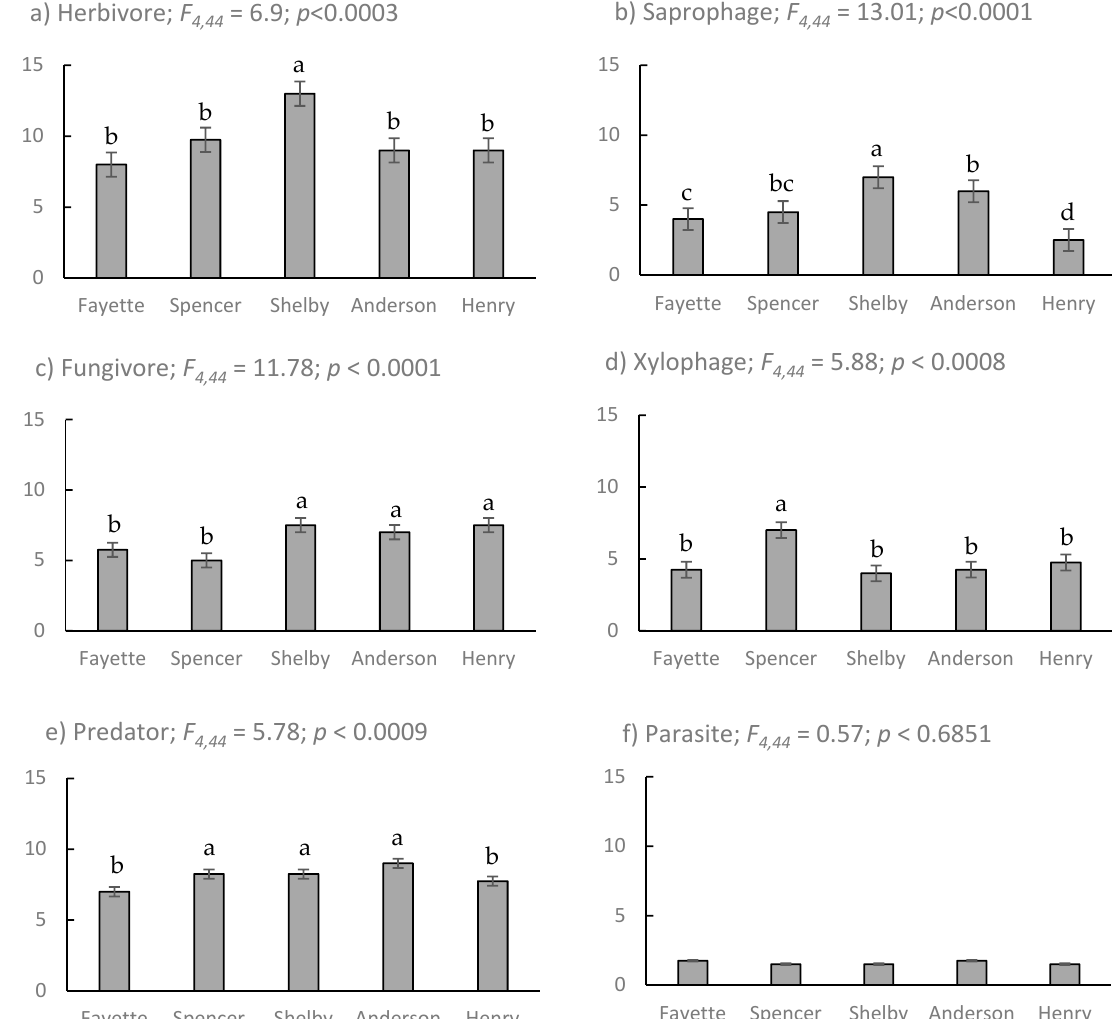
Figure 4. Coleopteran feeding guild abundance at five forested sites in north central Kentucky, including ( a ) herbivores, ( b ) saprophages, ( c ) fungivores, ( d ) xylophages, ( e ) predators, and ( f ) parasitoids. Means followed by the same letter do not differ ( α = 0.05). Among the predators, Trogossitidae and Cleridae abundance (7% and 5% of total predator abundance, respectively) were positively correlated ( α < 0.1) with ash decline (Figure 5).